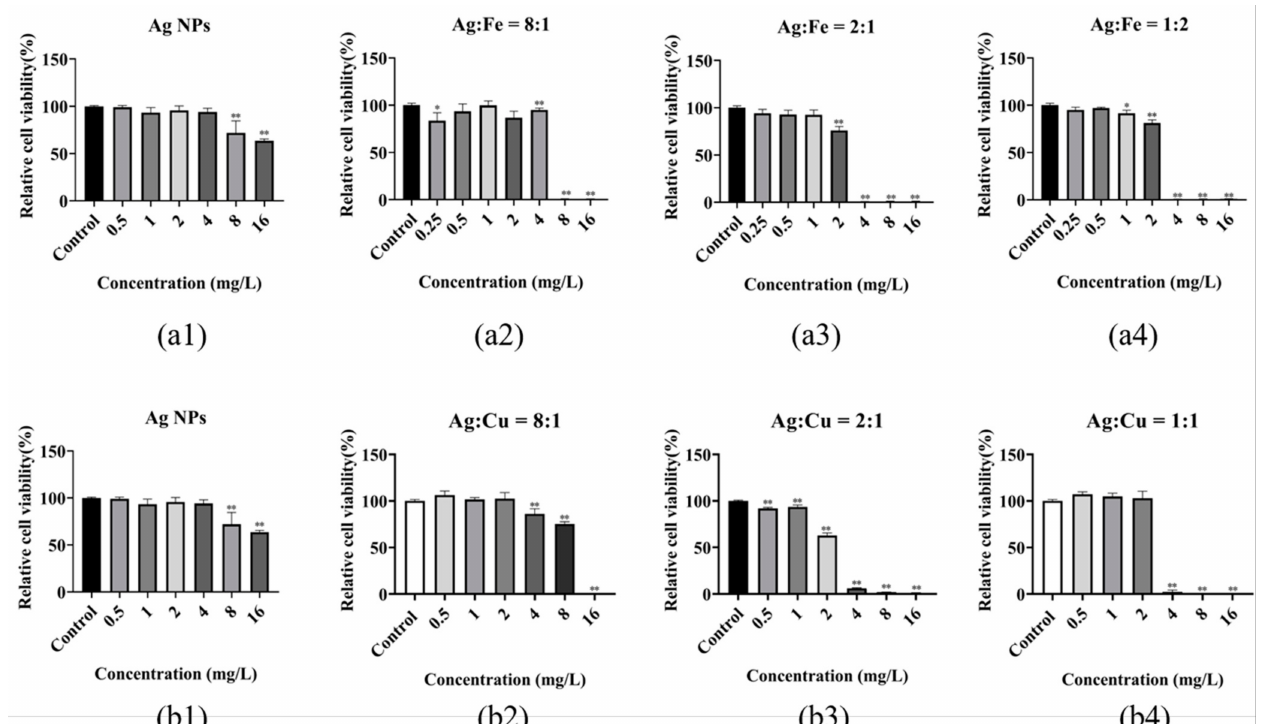
Figure 6. Concentration-dependent cytotoxicity of various Ag/M ratios. ( a1 , b1 ) for Ag NPs, ( a2 – a4 ) for AgFe NAs and ( b2 – b4 ) for AgCu NAs. Note: Compared to the control, * p < 0.05; ** p <